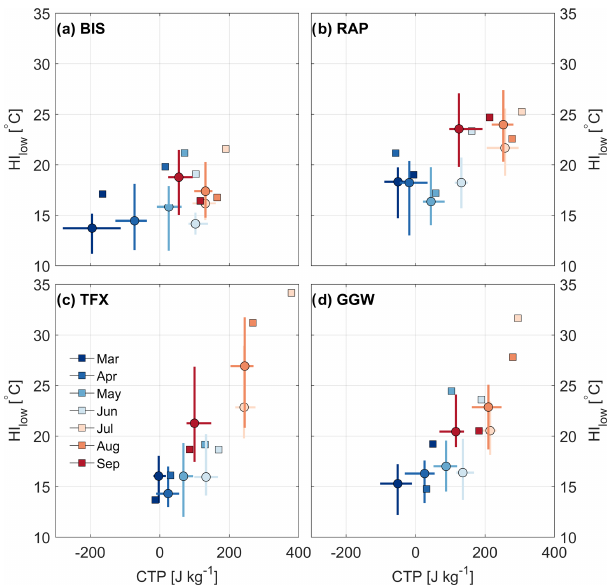
Figure 3. Seasonal development of mean monthly convective trig- gering potential (CTP) and lower tropospheric humidity index (HI low ) for 2017 (squares) compared to 30-year (1987–2016) me- dian (circles) and interquartile range (lines) of CTP and HI low for (a) Bismarck, ND (BIS); (b) Rapid City, SD (RAP); (c) Great Falls, MT (TFX); and (d) Glasgow, MT